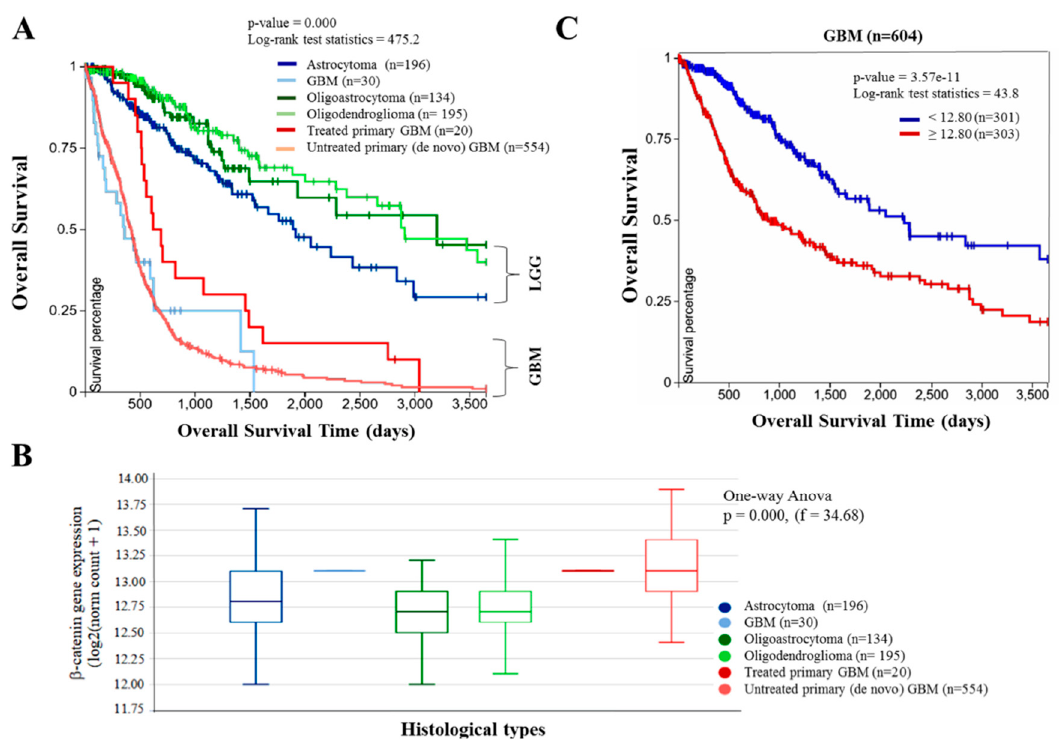
Figure 1. Aberrant expression of β -catenin is characteristic of glioblastoma (GBM) and correlates with poor prognosis. ( A ) Kaplan–Meier plot showing the overall survival of The Cancer Genome Atlas (TCGA) lower grade glioma and glioblastoma cohort (Glioma (GBMLGG), n = 1152) according to their histological type. ( B ) β -catenin expression across the different histological type of glioma and glioblastoma in the TCGA GBMLGG cohort. ( C ) Kaplan–Meier plot based on the β -catenin expression level in only the glioblastoma component of the TCGA GBMLGG dataset using the gene expression RNAseq-illuminaHiSeq. Expression cutoff is based on median expression. LGG, low grade glioma; GBM, glioblastoma.